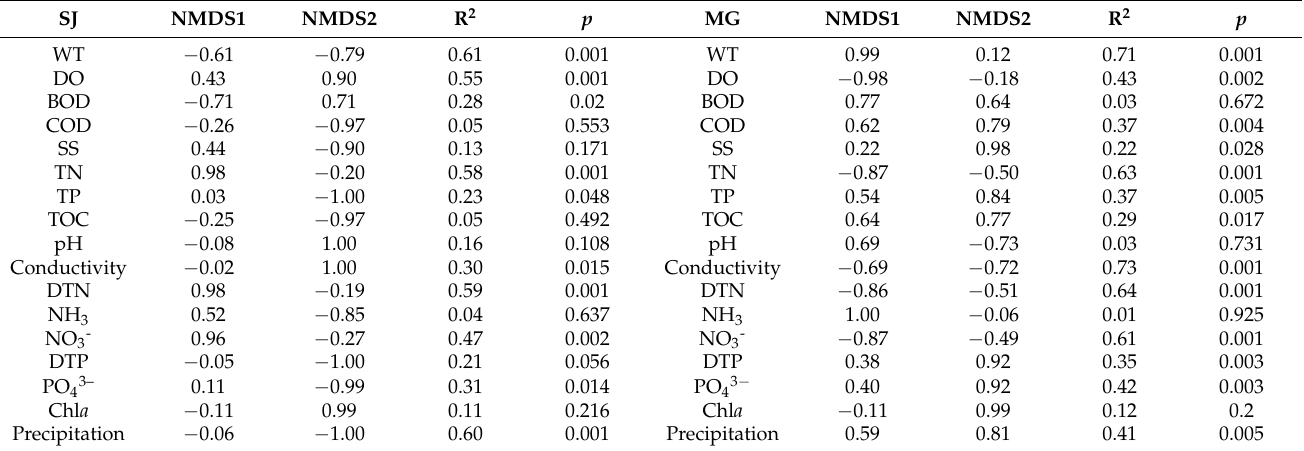
Table 2. Relationships between environmental factors and the non-metric multidimensional scaling (NMDS) ordination of micro-eukaryotic assemblages from eDNA metabarcoding. The meaning of abbreviations for the environmental variables is presented in Table